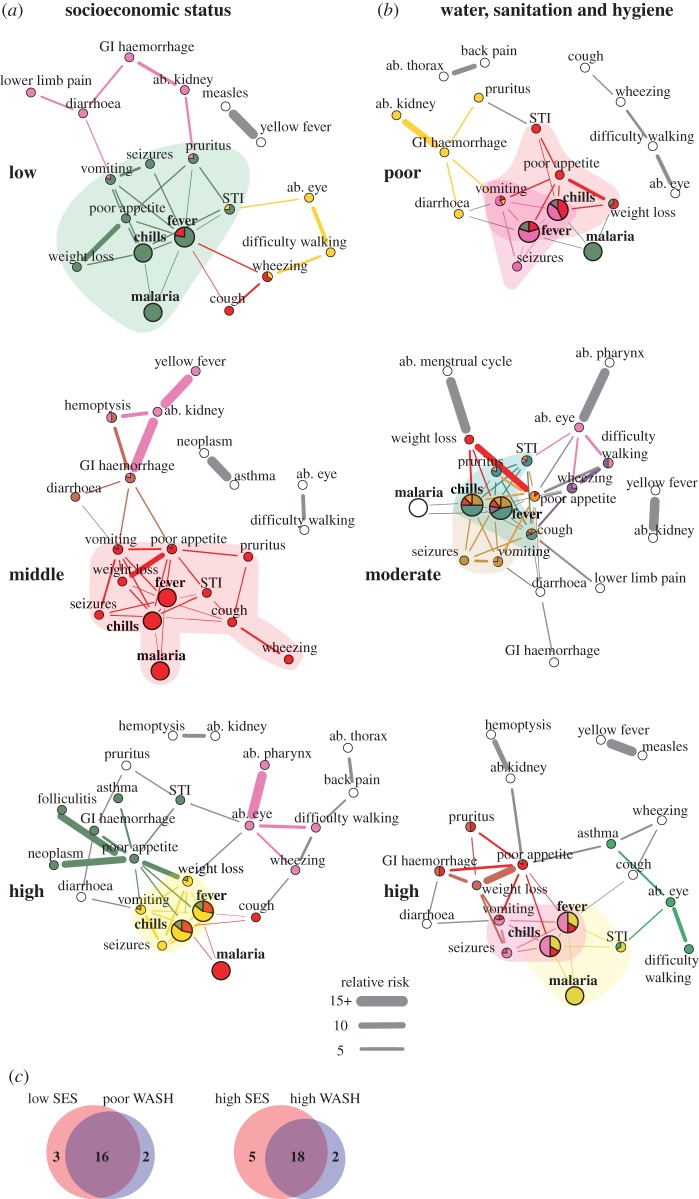
Comorbidity by SES and WASH. Nodes represent reported symptoms/diseases; HPO terms are shown for symptoms. ab. ‘abnormality of the’, GI ‘gastrointestinal’, STI ‘sexually transmitted infection’, SES ‘socioeconomic status’ and WASH ‘water, sanitation and hygiene’. Edges shown had relative risk (RR) > 1, ϕ > 0 and q-value < 0.05. Widths of edges are capped at a RR of 15. Colours correspond to link clusters; grey edges and white nodes were not grouped into a link cluster. The main clusters for fever are shaded as a visual aid. A main cluster was where a majority of edges for fever were grouped. If there was no majority, all clusters with greater than 1 edge with fever were highlighted/shaded. Bolded and enlarged nodes were the symptoms/diseases that were most often co-reported with another symptom/disease. A force-directed layout for comorbidity networks was used; the most connected symptoms/diseases are shown in the centre of the graphs. (a) Comorbidity by SES category. (b) Comorbidity by WASH category. (c) Overlap in symptoms/diseases (nodes) by SES and WASH categories.